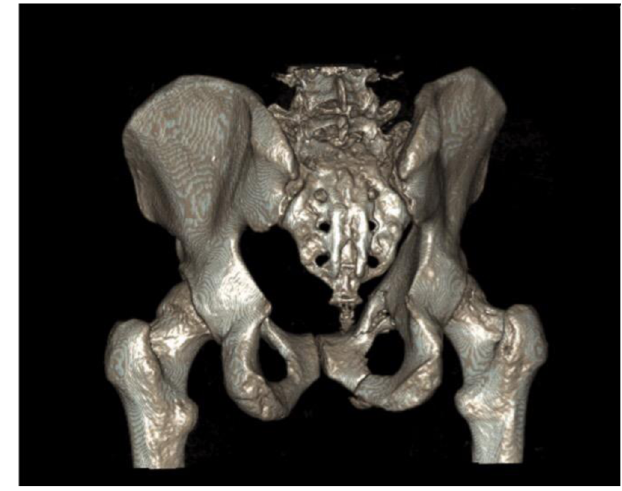
Figure 6. CT 3D reconstruction of Figure 5 injury.